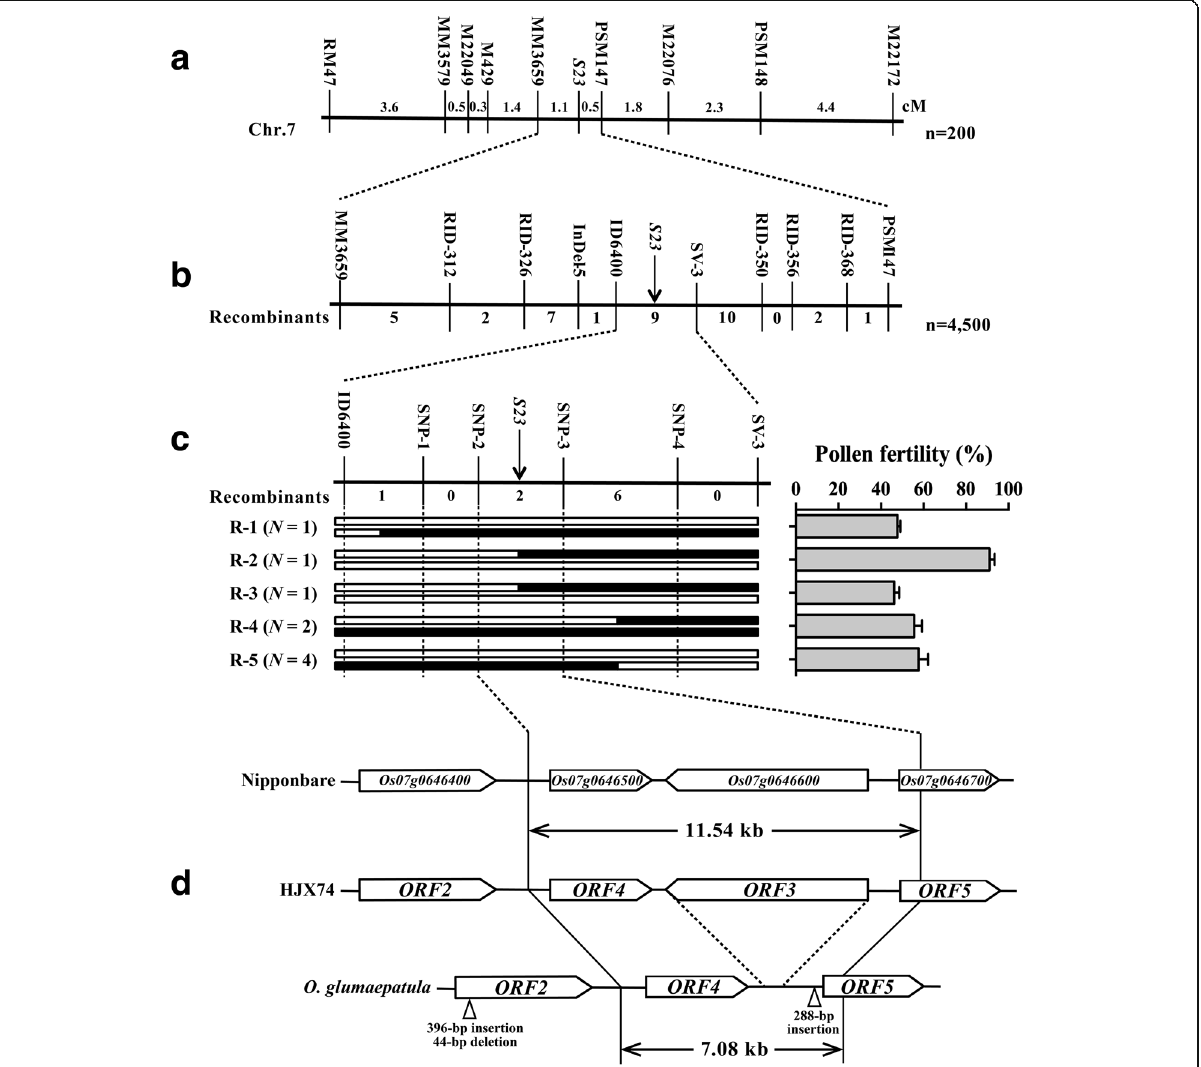
Fig. 4 Map-based cloning of S23 . (a and b) S23 was mapped to a 1.6 cM region flanked by MM3659 and PSM147 using 200 HJX74/SSSL-S23 F 2 plants ( a ), and was then fine-mapped to the region between ID6400 and SV-3 using 4500 HJX74/SSSL-S23 F 3 plants ( b ). c Nine key recombinants defined S23 to the region between SNP-2 and SNP-3. In Nipponbare genome, there were three genes in the 11.54 kb target region between SNP-2 and SNP-3. White and black boxes indicated chromosomal segments from HJX74 and O. glumaepatula , respectively. Genetic distance and the number of recombinants between adjacent markers was shown above and below the bar, respectively. d Sequence analysis was performed for the fine-mapped region and neighbouring region of HJX74 and O. glumaepatula , and ORFs were